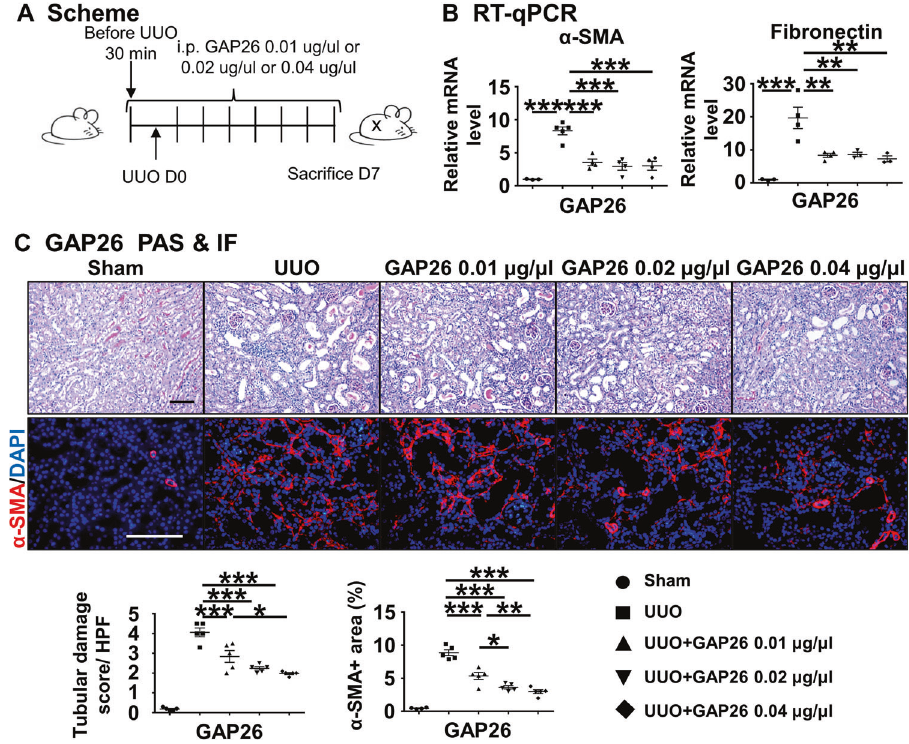
Fig. 2 Cx43 hemichannel blocker attenuates kidney injury and RIF after UUO. A Scheme. mice were treated with GAP26 by i.p. injection after UUO surgery. B RT-qPCR. Levels of mRNA encoding α -SMA, Fibronectin by RT-qPCR. C PAS and immuno fl uorescence staining. PAS staining was performed to evaluate renal tubular injury by calculating tubules about GAP26. α -SMA is a marker of myo fi broblast. Corresponding graphs indicate the expression of α -SMA for evaluation of myo fi broblast in fi ltration. Data are presented as the mean ± SEM, n = 4 – 7/group, * P < 0.05, ** P < 0.01, *** P < 0.001; Scale bar: 100 μ